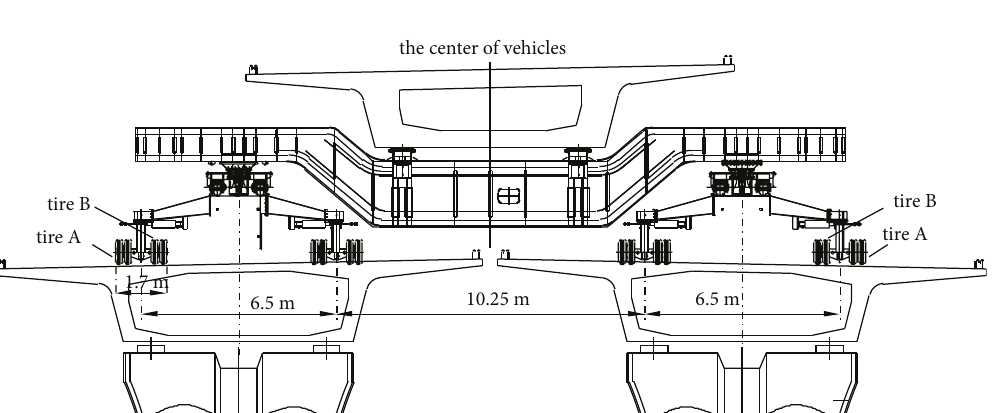
Figure 3: End section (cm).